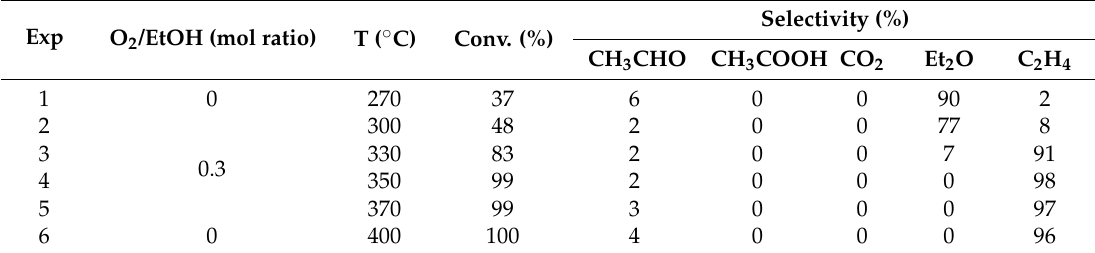
Table 2. Performance of cat G (0.5% Au/silicalite) in ethanol conversion.